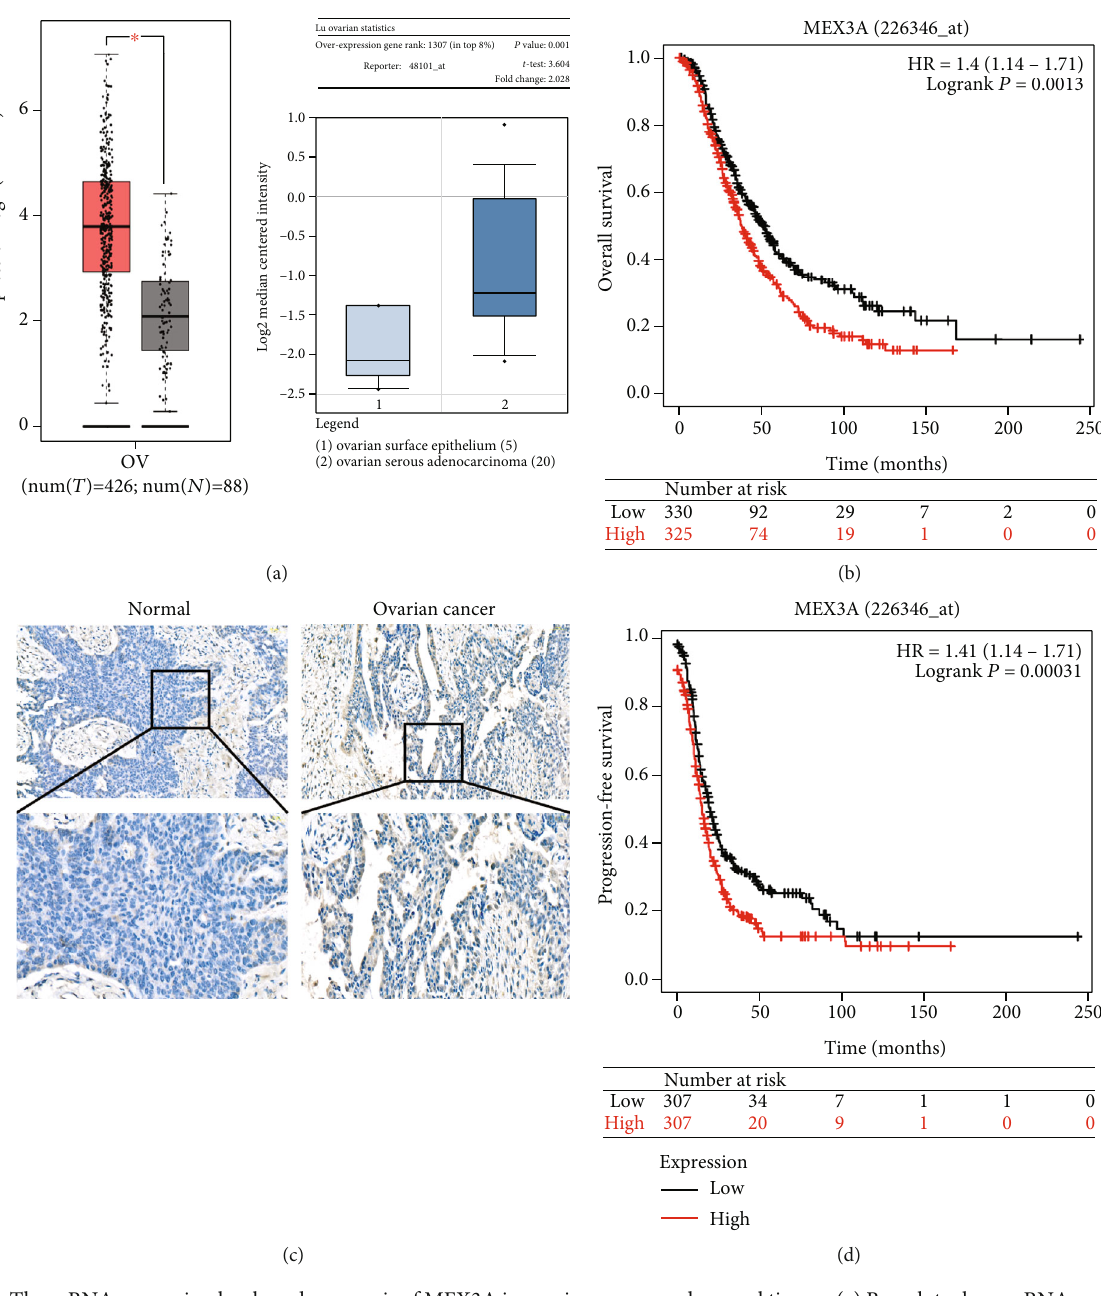
Figure 1: The mRNA expression levels and prognosis of MEX3A in ovarian cancer and normal tissues. (a) Box plots show mRNA expression of MEX3A in OC tissue (red plot) and normal tissues (gray plot) from GEPIA. (b) Prognostic signi fi cance of MEX3A in OC with OS from the Kaplan – Meier plotter. (c) Representative IHC images of MEX3A expression in normal tissue and ovarian cancer. (d) Prognostic signi fi cance of MEX3A in OC with PFS from the Kaplan – Meier plotter. The red survival curve represents high MEX3A expression, and the black survival curve represents low MEX3A expression in OC. ∗ P < 0 : 05 , ∗∗ P < 0 : 01 , and ∗∗∗ P < 0 : 001